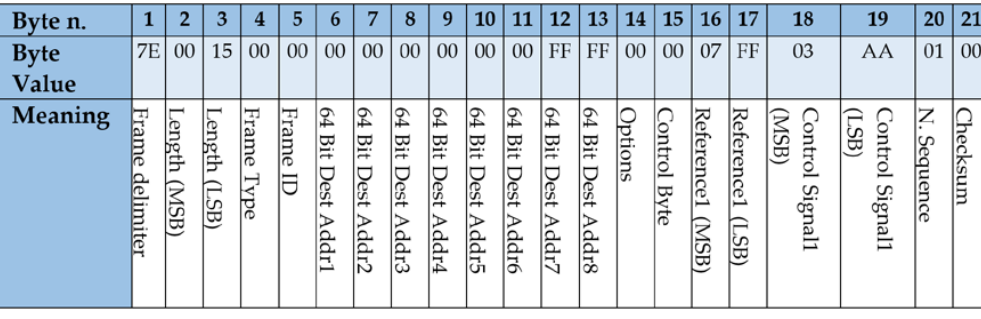
Figure 4. Control frame issued by the Wireless Controller to the Edge Nodes for a SISO control system.